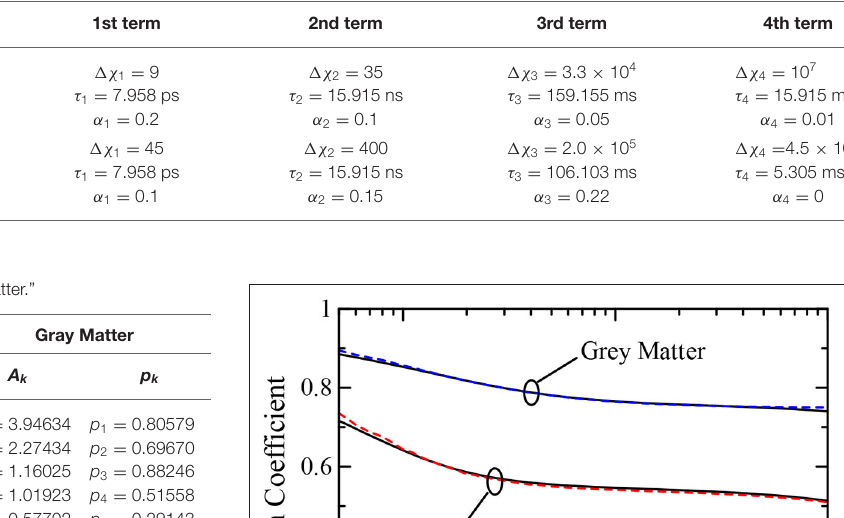
TABLE 1 | Cole–Cole parameters for “Fat” and “Gray Matter” from Gabriel’s database.